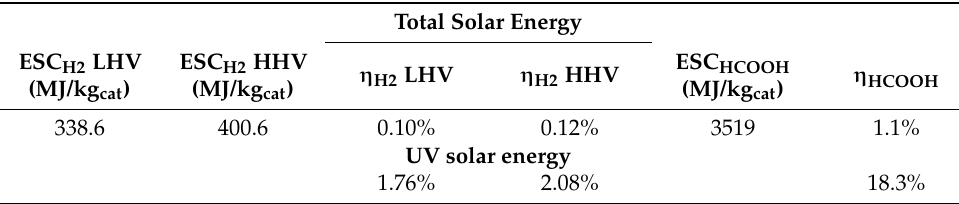
Table 5. Energy Storage Capacity that can be potentially stored in HCOOH and in H 2 , i.e., the main products, through the photoreduction of CO 2 and efficiency calculated based on total and UV solar radiation. Data referred to catalyst